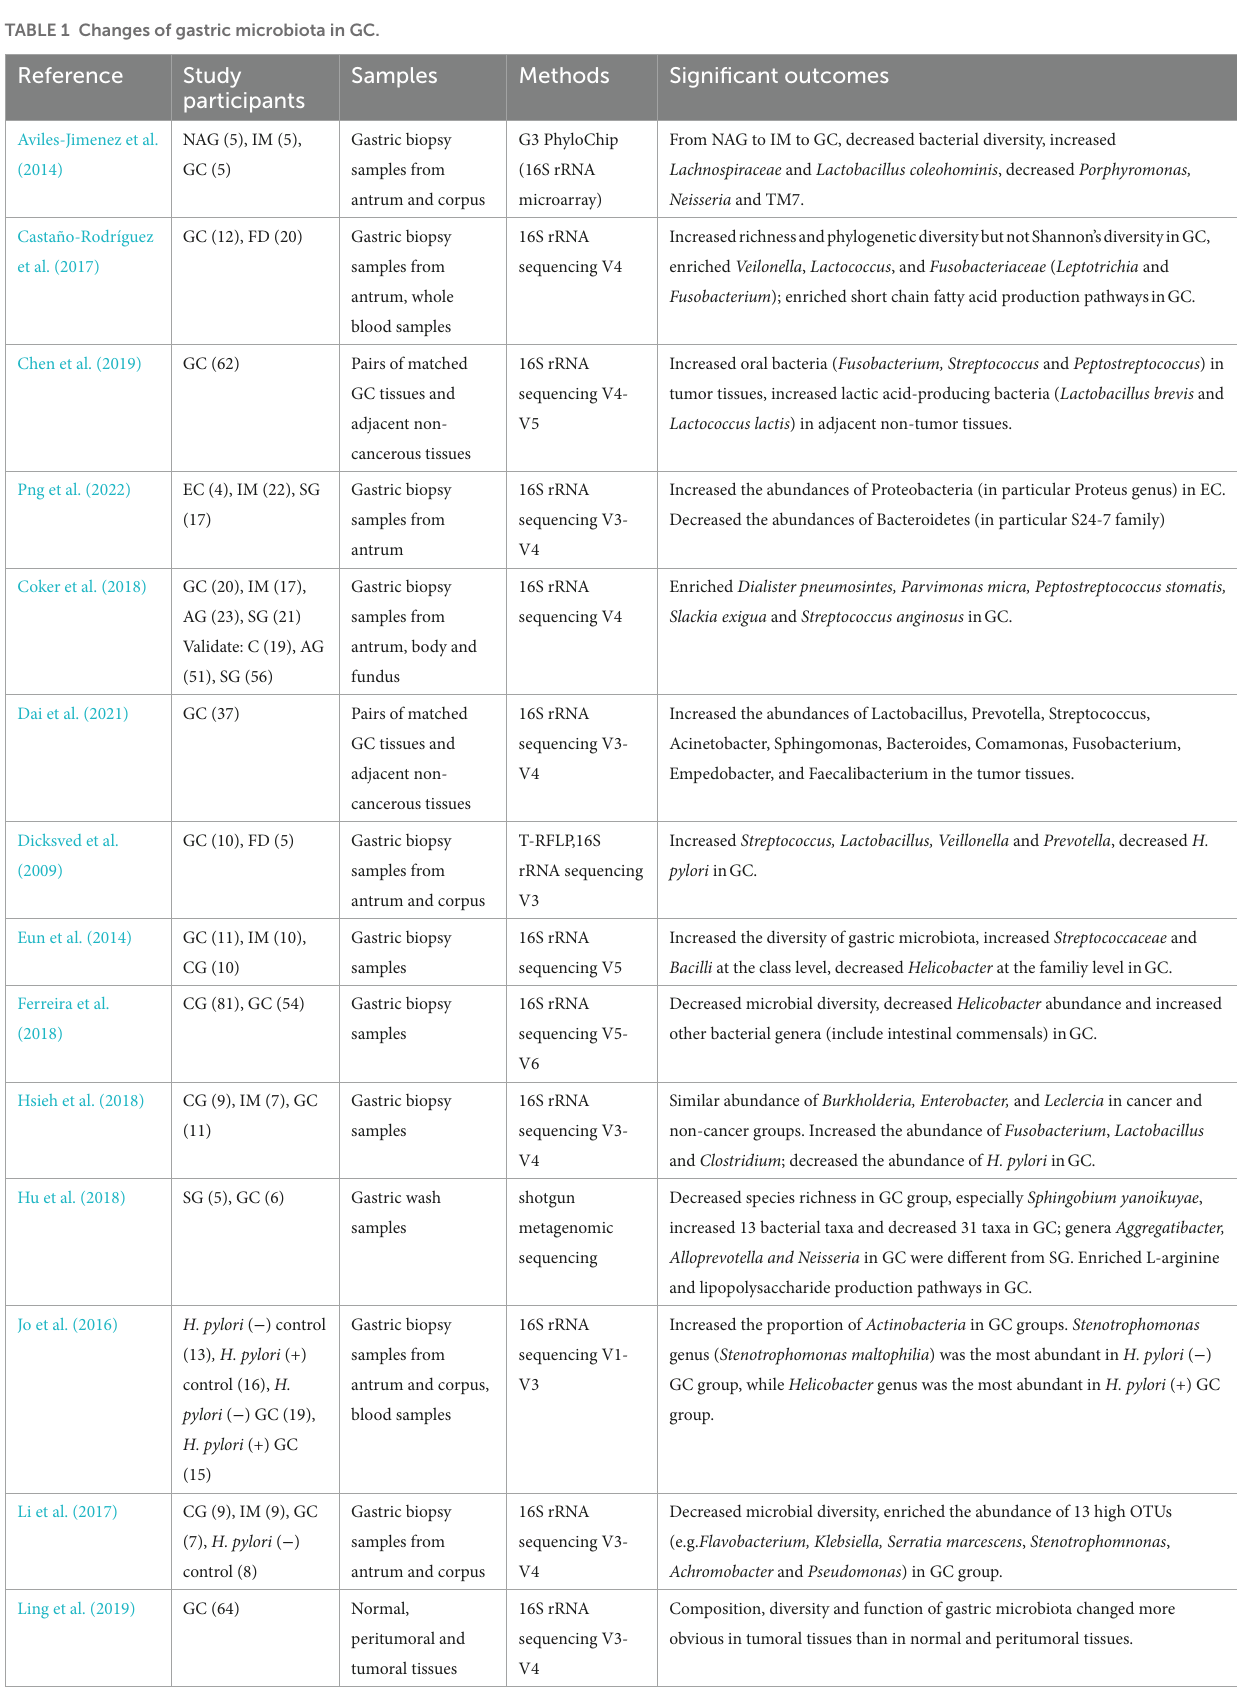
TABLE 1 Changes of gastric microbiota in